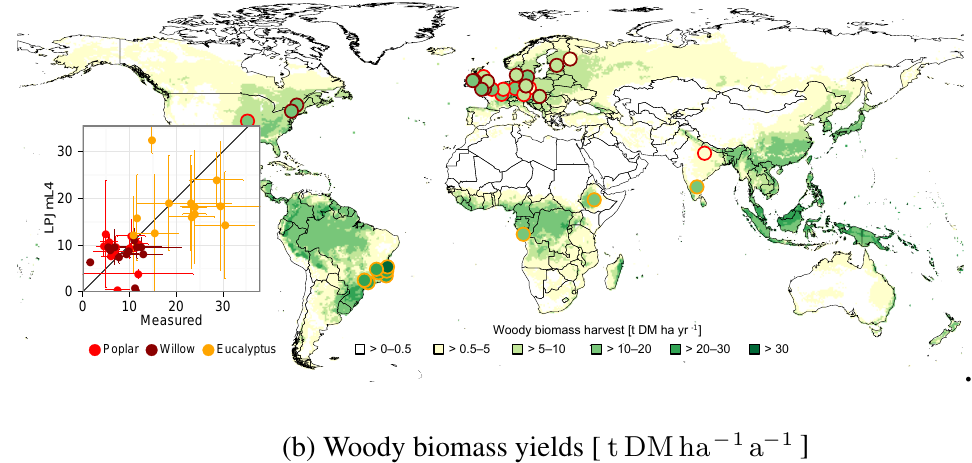
Figure 13. Map of simulated biomass yields by LPJmL4 from rain-fed herbaceous (a) and woody (b) BFTs (averages 1994–2009). Dots indicate the location of the experimental sites and measured yield, with colours scaled to map colours. Scatterplots compare observed and simulated yields in the respective grid cells. Model uncertainty is derived from simulations with and without irrigation. Observation uncertainty reflects dependencies on plantation management (adapted from Heck et al.,